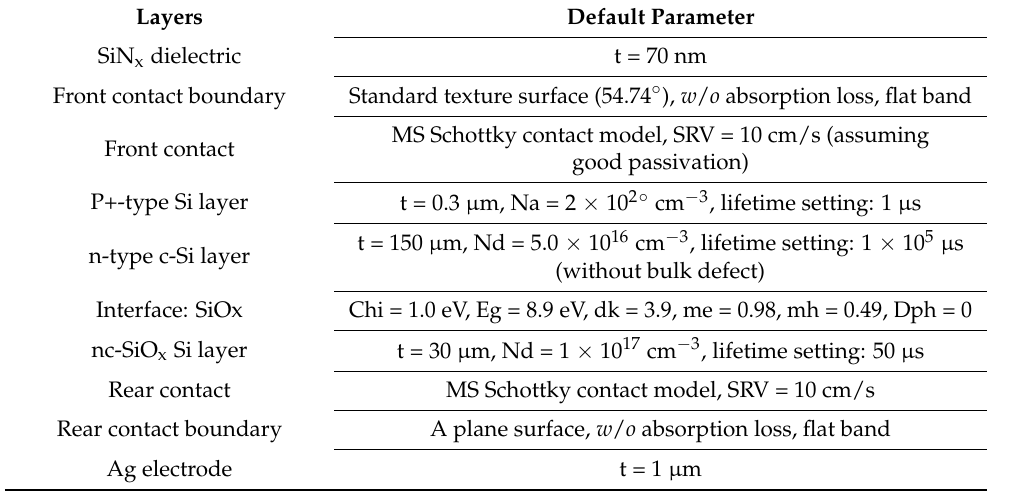
Table 1. Simulation Parameters for TOPCon Solar Cell.